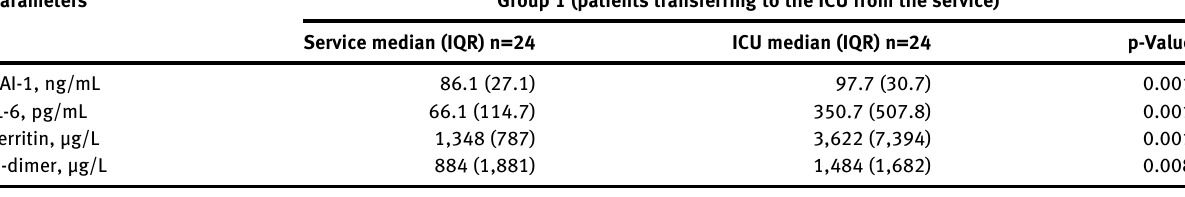
Table  : Mean values of same patients dependent grouped according to hospitalization unit changes.